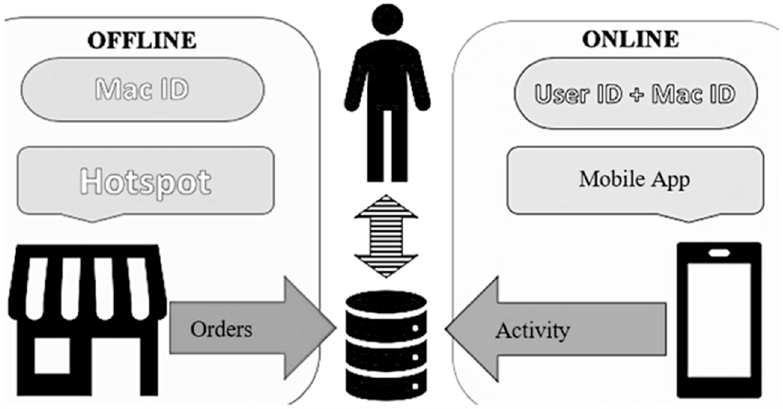
Figure 2. Model of interaction of the main components in a phygital environment.